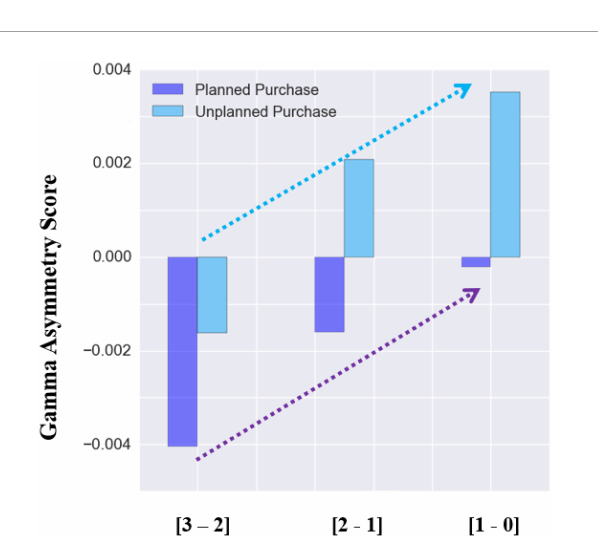
FIGURE7 Gamma asymmetry score (averaged for all subject over all purchased items) for the three 1-s epochs before choosing a product. The horizontal axis shows the three time-intervals (within the 3 s window) before choosing a product.